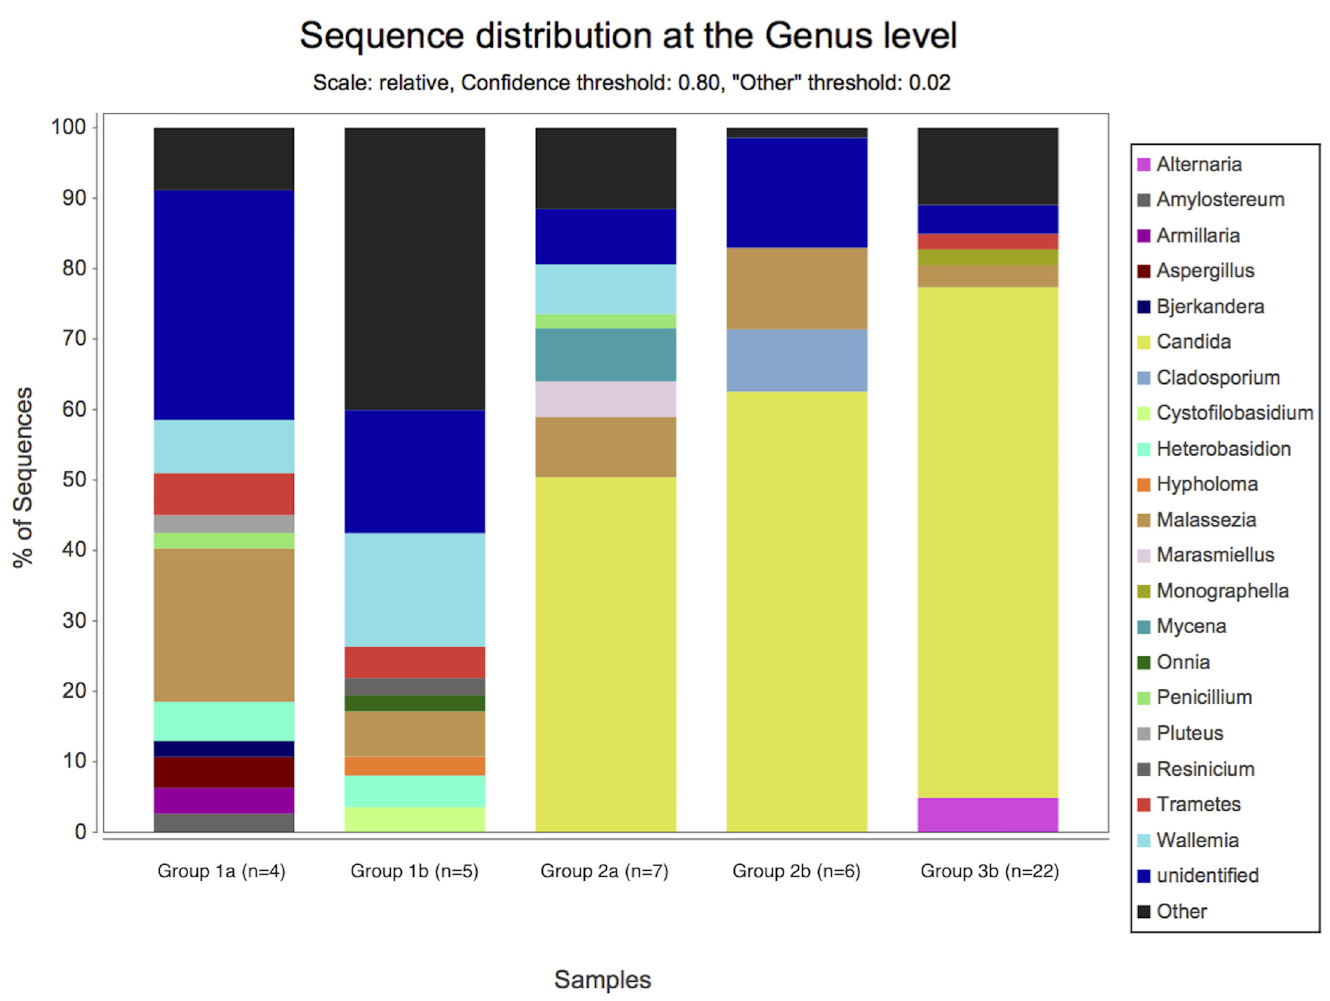
Fig 2. Relative abundance of fungal microbiota in lower respiratory tract samples. Healthy adults (bar group 1a), patients with healthy respiratory tract but with antibiotic therapy for extrapulmonary infection (bar group 1b), non-neutropenic intubated and mechanically ventilated ICU patients without antibiotic therapy (bar group 2a), non-neutropenic intubated and mechanically ventilated ICU patients with antibiotic therapy for extrapulmonary infection (bar group 2b), and patients with antibiotic therapy due to pneumonia (bar group 3b). Fungi are shown at genus level. Yellow bars represent the sum of Candida sequences across all samples per group related to the total number of detected fungal sequences within each of the groups. By conventional culture Candida spp . were detected in 0/8 (group 1a), 0/7 (group 1b), 1/7 (group 2a), 3/6 (group 2b), and 11/26 (group 3b) patients. No other fungi were cultured.